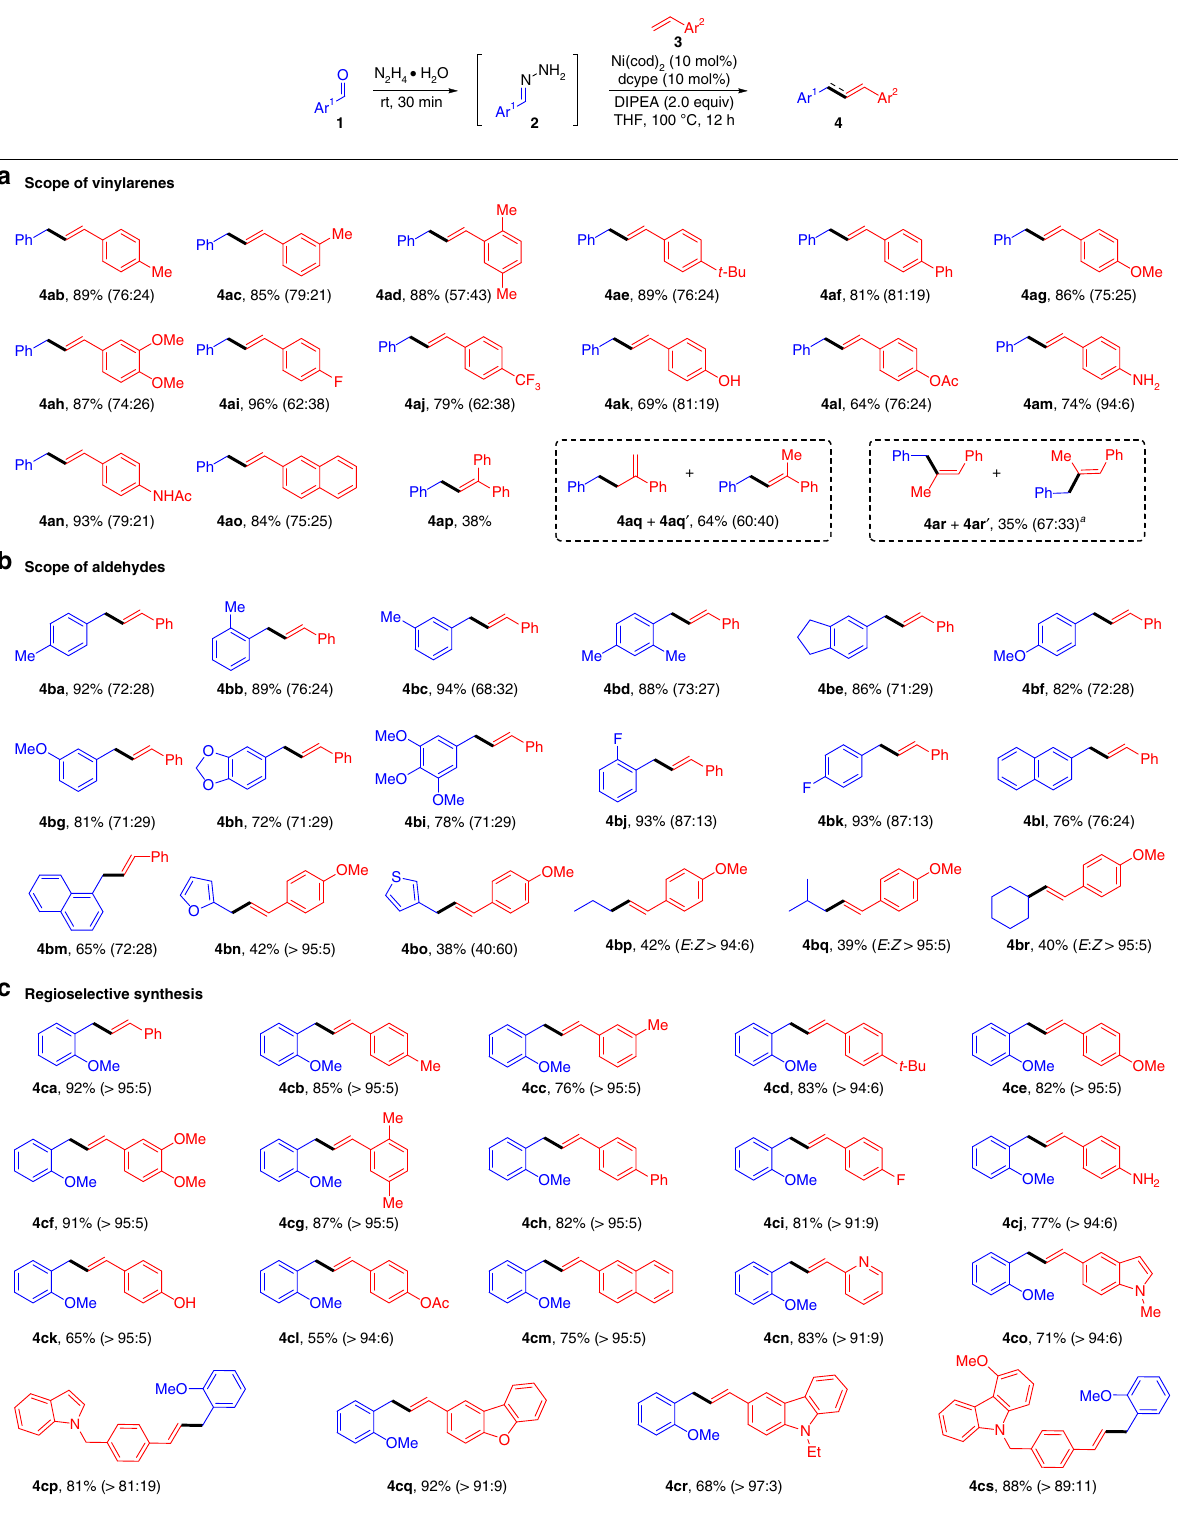
Fig. 2 Scope of substrates. Reaction conditions: 3 (0.2 mmol), 1 (0.6 mmol), N 2 H 4 (cid:129) H 2 O (0.72 mmol), Ni(cod) 2 (10 mol%), dcype (10 mol%), DIPEA (0.4 mmol), NaI (0.1 mmol), THF (1.0 mL), 100 °C, 12 h under N 2 . Reported yields are the isolated ones (the ratio of allylic isomerization was in parentheses), the E :Z ratio was more than 20:1 unless otherwise noted. a The Z: E ratio in